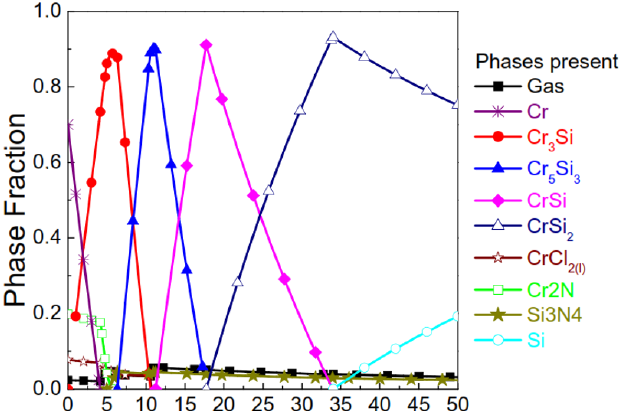
Figure 2. Amount of equilibrium phases formed during pack cementation process as a function of the Si